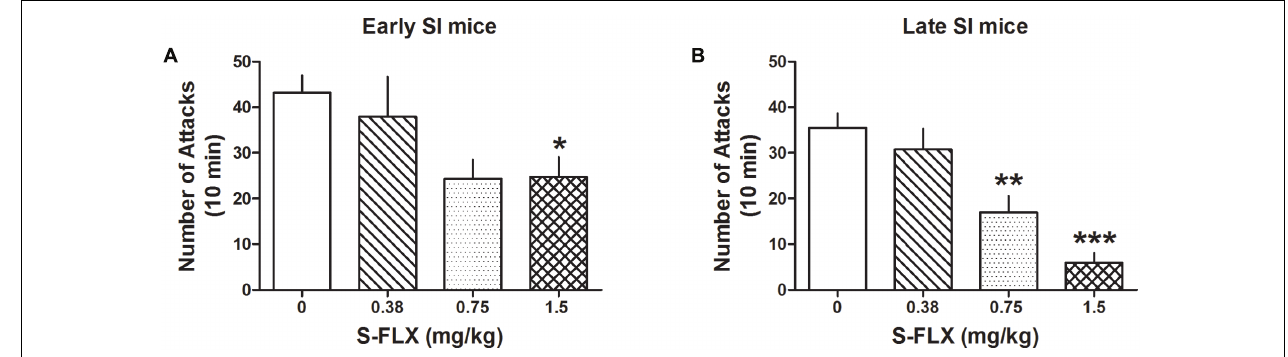
FIGURE 2 | S -fluoxetine ( S -FLX) decreases aggressive behavior in early and late adolescent SI mice. S -FLX at the doses of 0.375, 0.75, and 1.5 mg/kg, i.p., was administered both to early (A) and late (B) adolescent SI mice 60 min before the resident–intruder test. In late adolescent SI mice, S -FLX reduced aggression at the dose of 0.75 mg/kg with an EC 50 dose of 0.85 mg/kg, while in early adolescent SI mice, S -FLX induced a decrease of aggression with an EC 50 dose of > 1.5 mg/kg. Data represent the mean ± SEM of 13–18 mice. ∗ p < 0.05; ∗∗ p < 0.01; ∗∗∗ p < 0.001, when compared with basal control levels of aggression.